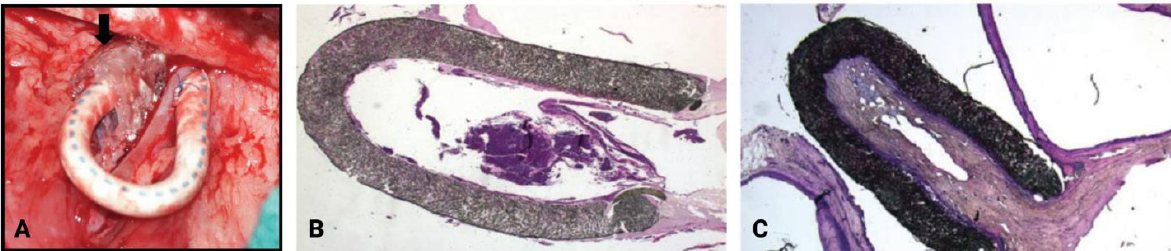
Figure 5. ( A ) Placement of perivascular paclitaxel wraps at the graft-vein anastomosis in a swine model. ( B , C ) Hematoxylin and eosin (H&E) staining (magnification, 100x) shows a marked decrease in NIH at the graft-vein anastomosis when treated with a paclitaxel-loaded perivascular wrap ( B )